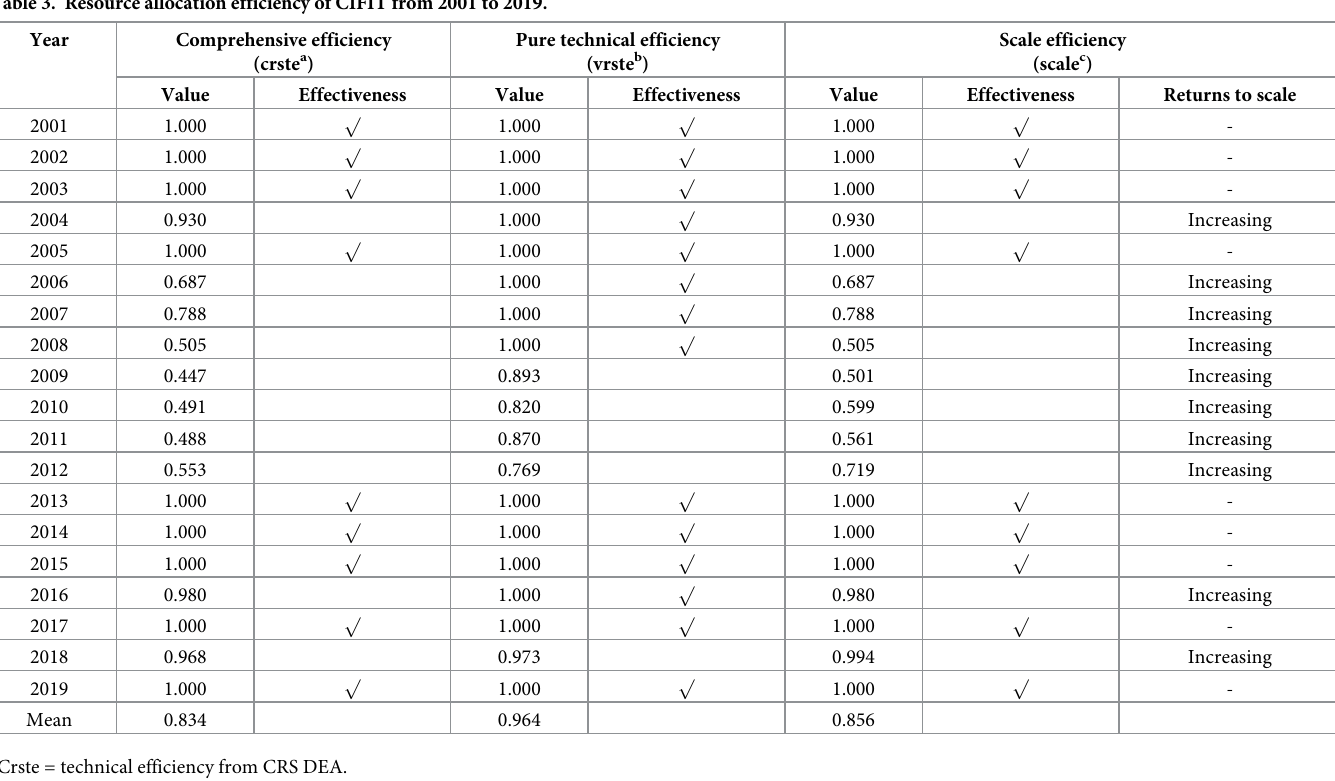
Table 3. Resource allocation efficiency of CIFIT from 2001 to